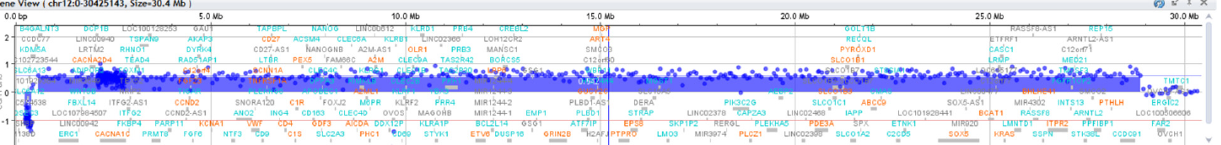
Figure 7. Genetic tests for patient 4. Array CGH result—DNA extracted from a peripheral